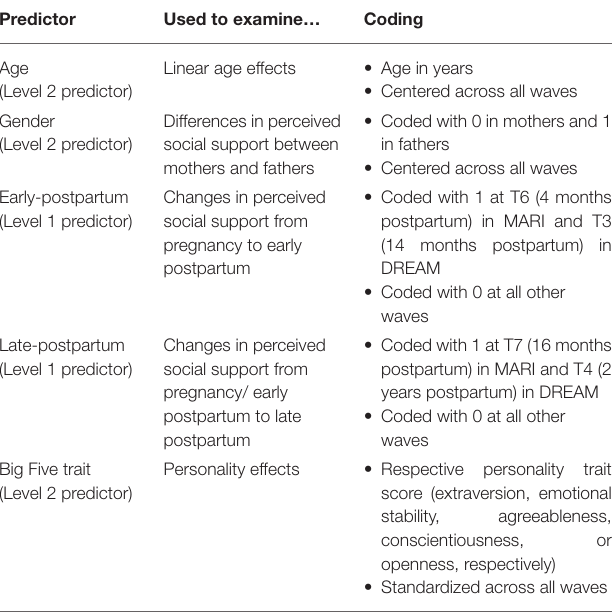
TABLE 2 | Baseline sample characteristics of the MARI sample ( N =